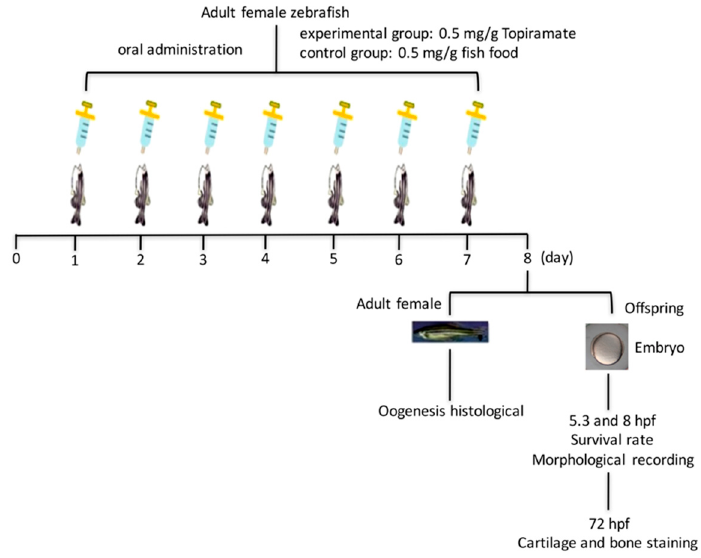
Figure 5. Experimental design scheme of topiramate treatment in zebrafish.